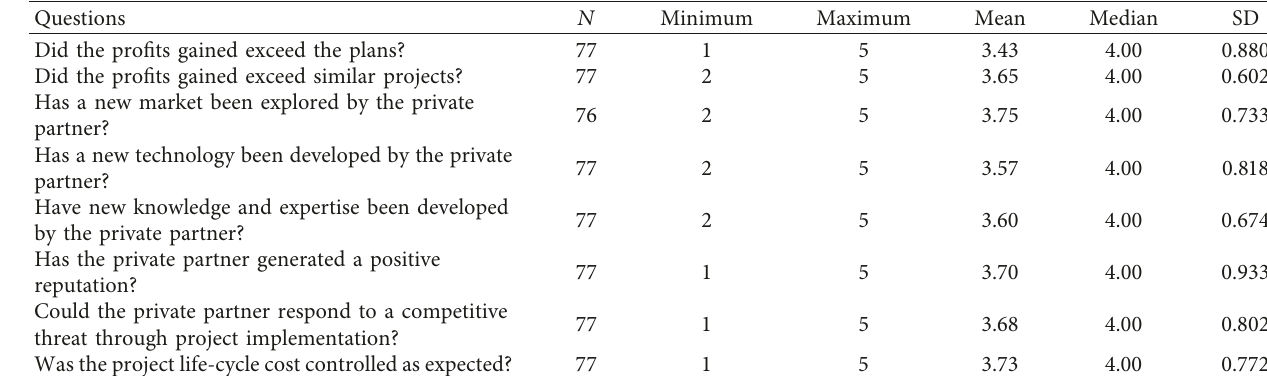
Table 5: Descriptive data of the project success dimension “benefits to private